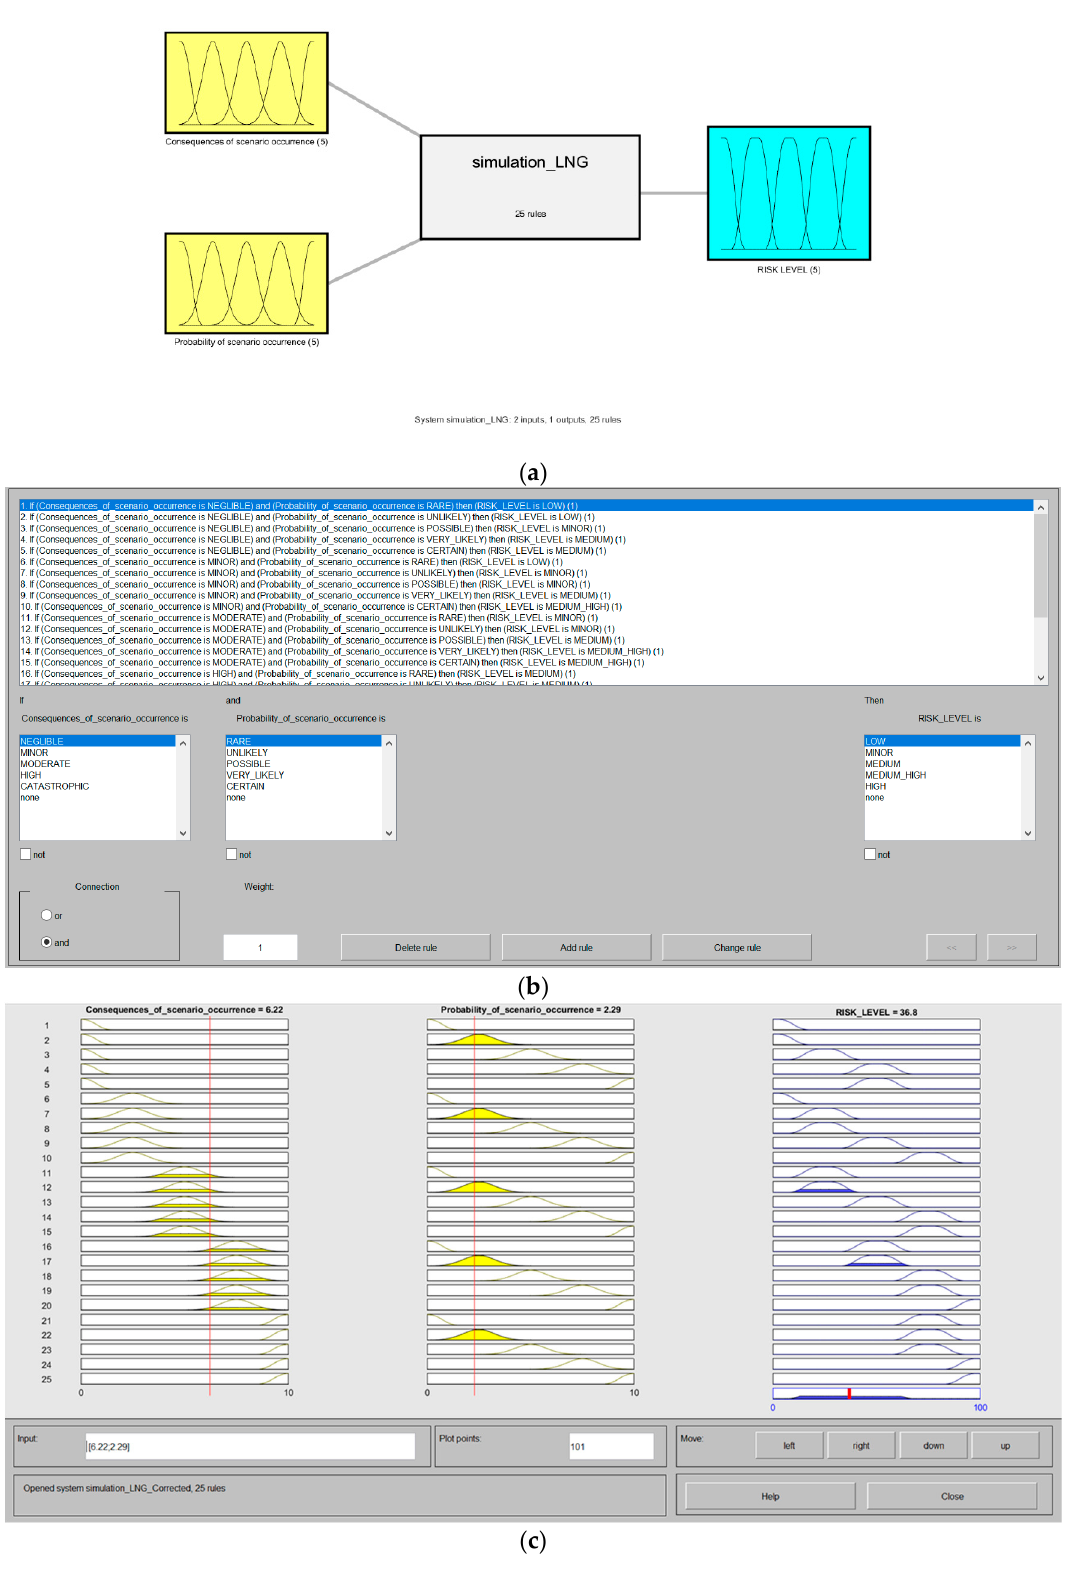
Figure 8. Result of using Mamdani fuzzy model in MATLAB: ( a ) View of the model; ( b ) FIS engine; ( c ) rules viewer.